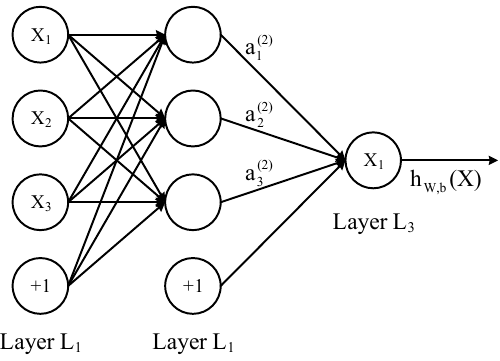
Figure 2. This is a simple model for DNN structure.